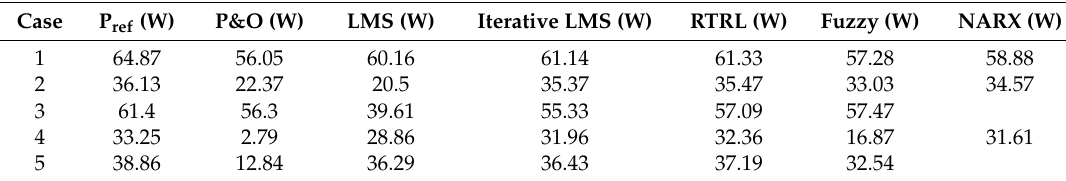
Table 2. Maximum power obtained with each control algorithm.